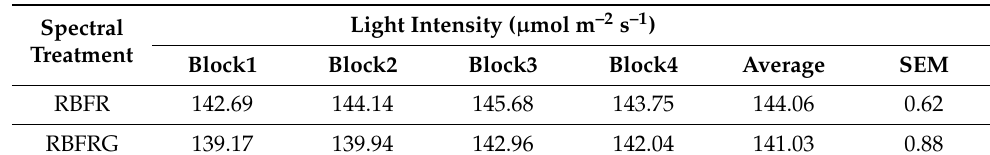
Table A2. Total PAR (400–700 nm) measured in four replicates for the two spectral treatments in Experiment 2.